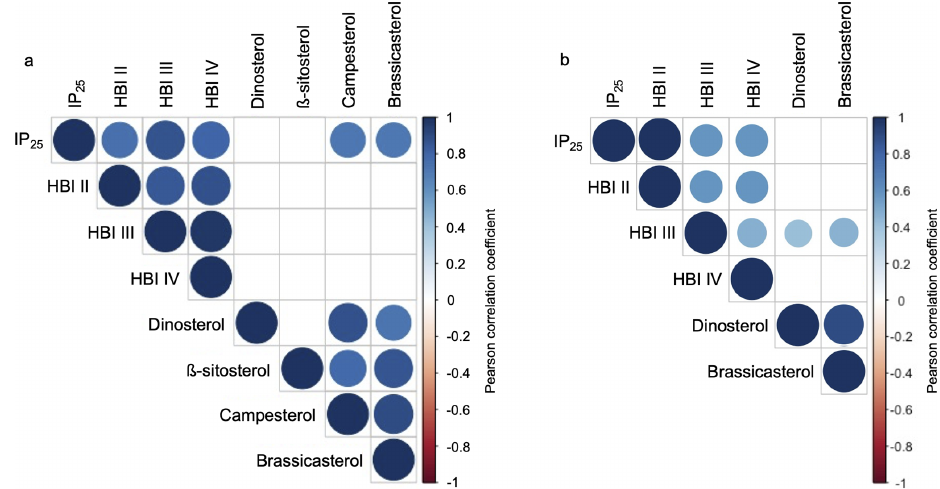
Figure 5. Pearson correlation coefficients between HBIs and sterols for (a) this study’s samples ( n = 13) and (b) the subset of Kolling et al. (2020, n = 70). Positive correlations are displayed in blue, and negative correlations are shown in red. Both the color and size of the circle are proportional to the correlation coefficients. Insignificant correlations ( p values > 0.01) are left